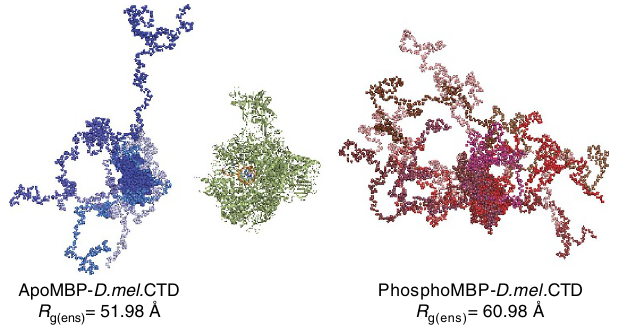
Figure 3 | Ensemble optimization models depicting CTD extension. Averaged apo and phospho MBP- D.mel CTD scattering data were modelled using EOM 2.1 from the ATSAS suite 31 . Individual models in the apo and phospho ensembles are shown in shades of blue and red, respectively, oriented by MBP and positioned adjacent to the 12 subunit RNA Pol II elongation complex (1Y1W.pdb) model (green) for